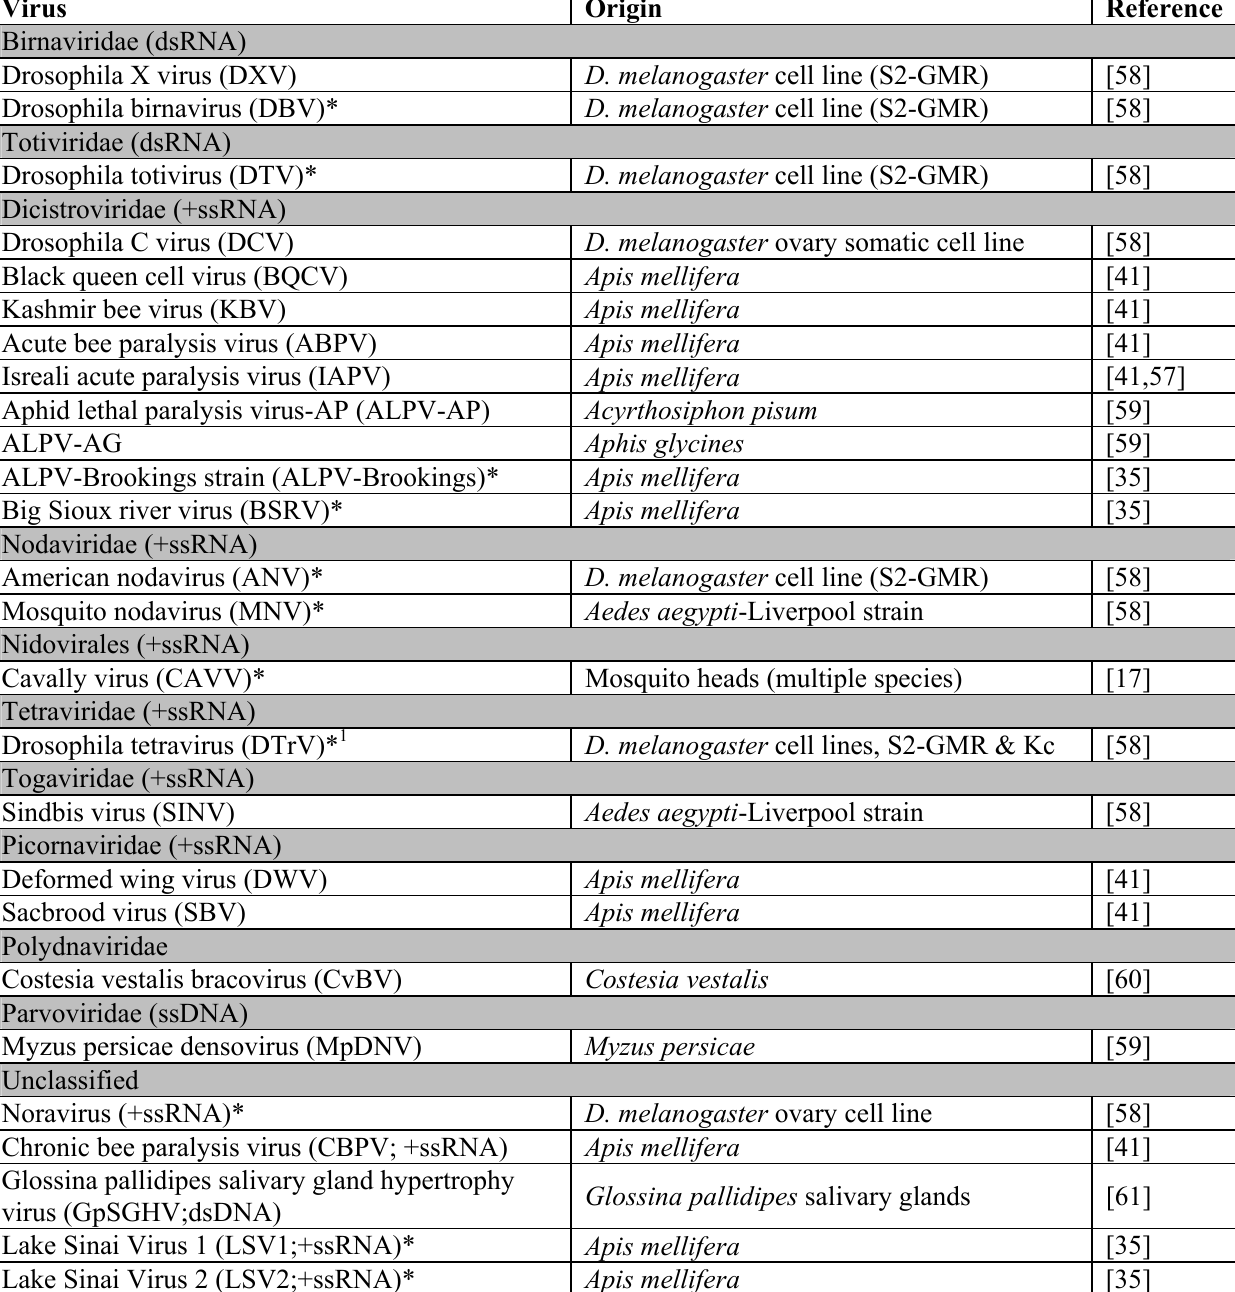
Table 3. Insect viruses detected/discovered by use of Next Generation Sequencing